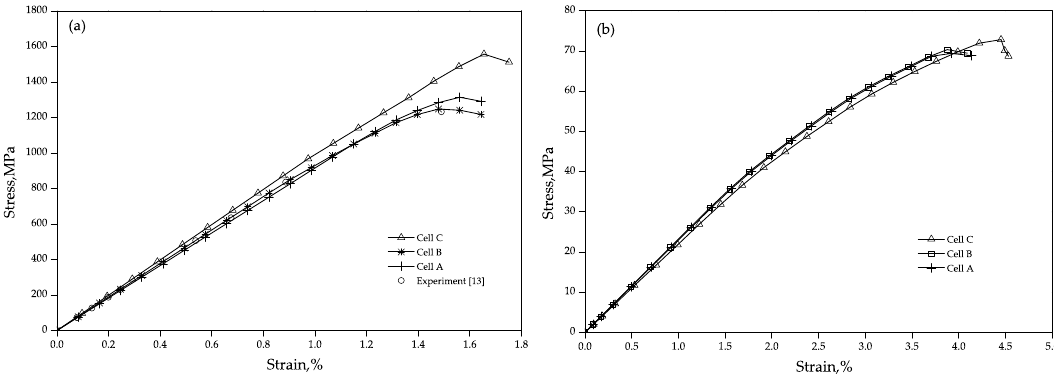
Figure 9. Typical stress ‐ strain curve of micromechanical non ‐ crimp fabric (NCF) unit cells computations: ( a ) longitudinal tensile loads in 1 ‐ direction; and ( b ) shear in 1–2 plane.